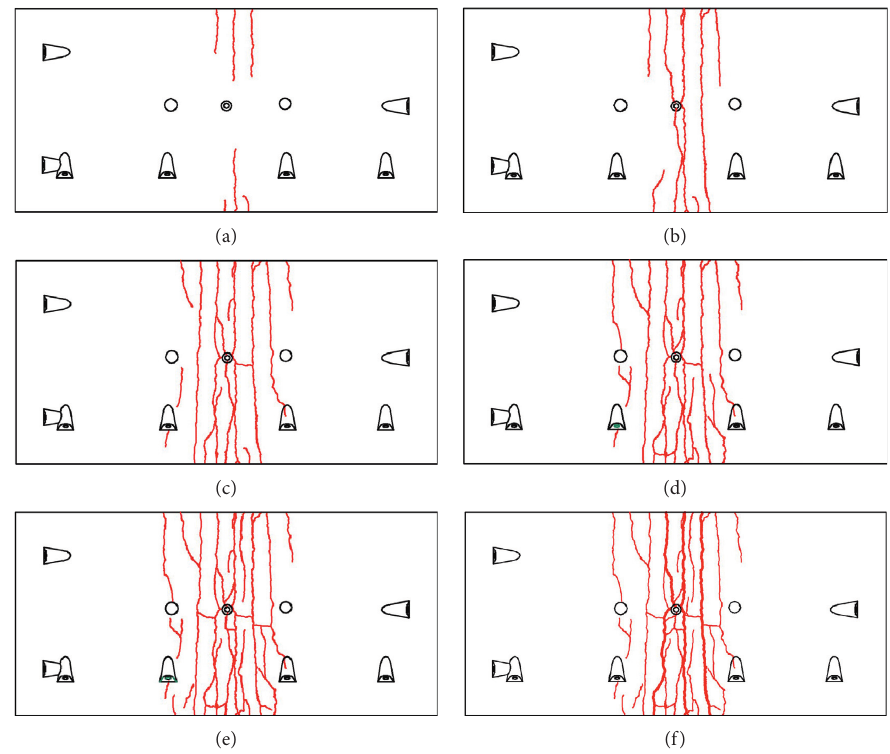
Figure 12: Development of cracks in the surface of the arc in the intermediate ring. (a) Vertical load � 1901 kN, (b) vertical load � 2182kN, (c) vertical load � 2533kN, (d) vertical load � 2784kN, (e) vertical load � 3035kN, and (f) failure load � 3482kN.